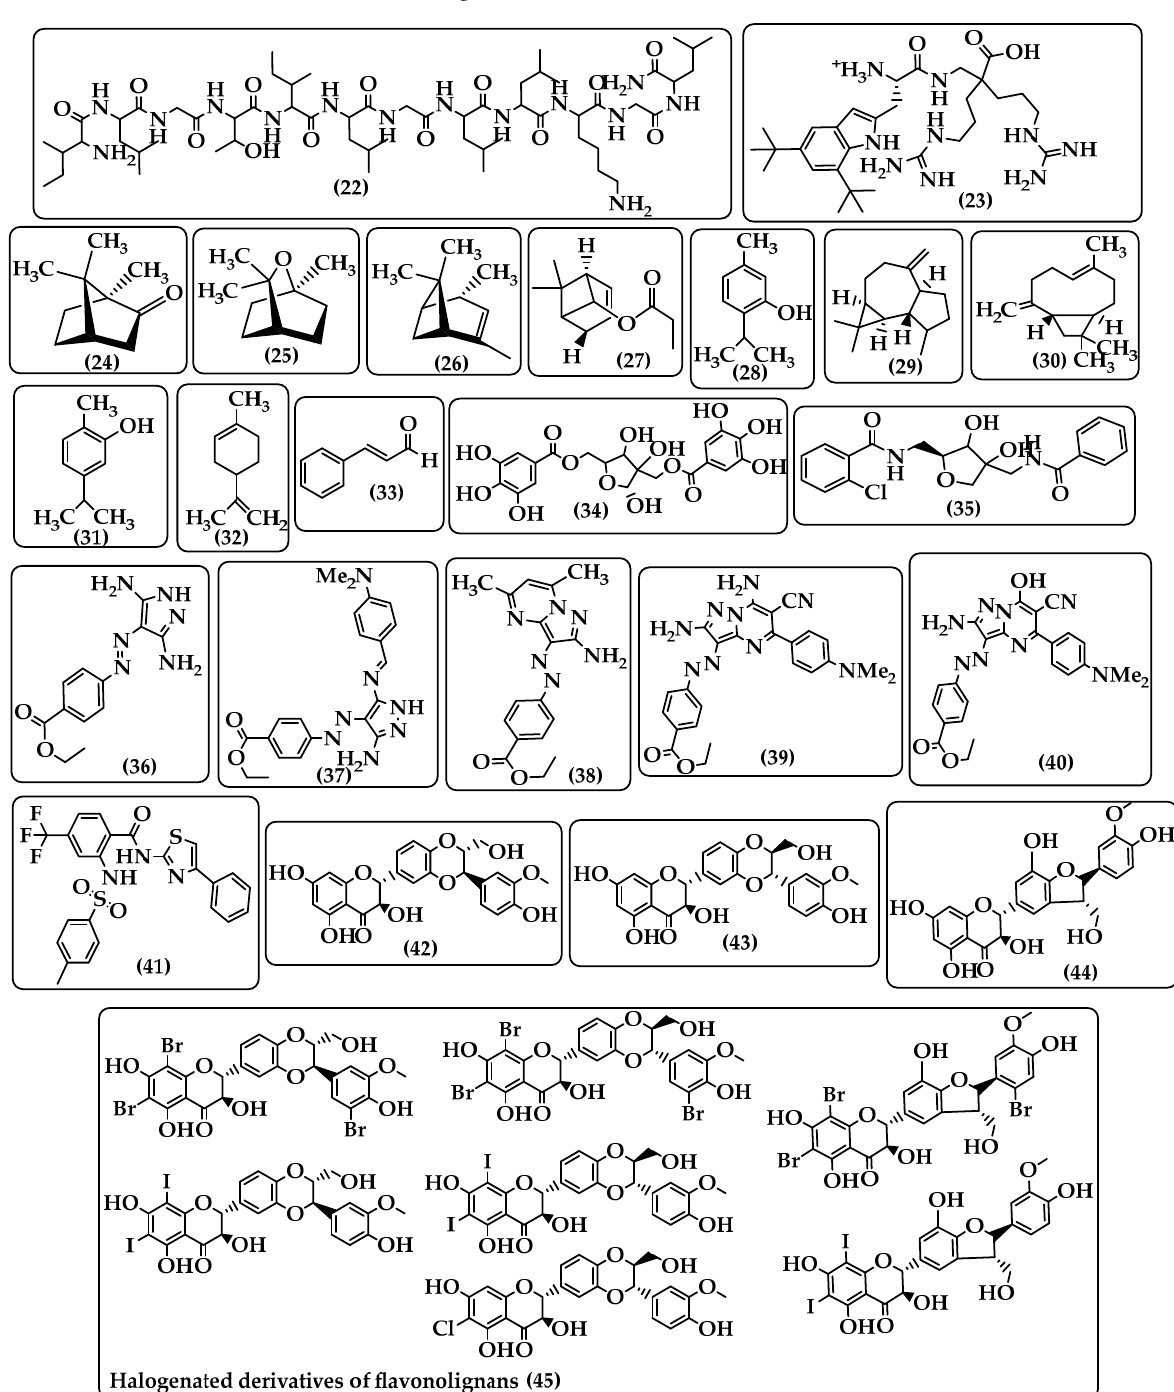
Figure 10. Chemical structure of protonectin ( 22 ), Tbt- β 2,2 h bis-Arg-OMe compound ( 23 ) camphor ( 24 ), 1,8-cineole ( 25 ) alpha-pinene ( 26 ), trans-chrysanthenyl acetate ( 27 ), thymol ( 28 ), aromadendrene ( 29 ), and β -caryophyllene ( 30 ), carvacrol ( 31 ), limonene ( 32 ), cinnamaldehyde ( 33 ),